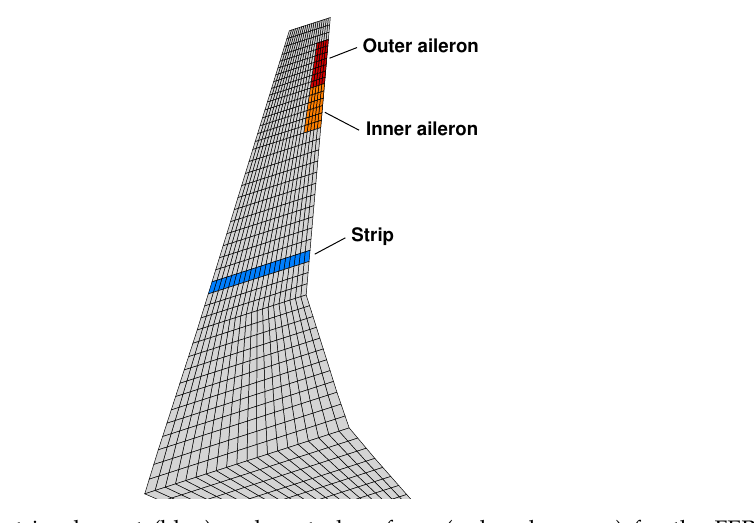
Figure 8. Typical strip element (blue) and control surfaces (red and orange) for the flutter reduced order assessment (FERMAT) configuration.